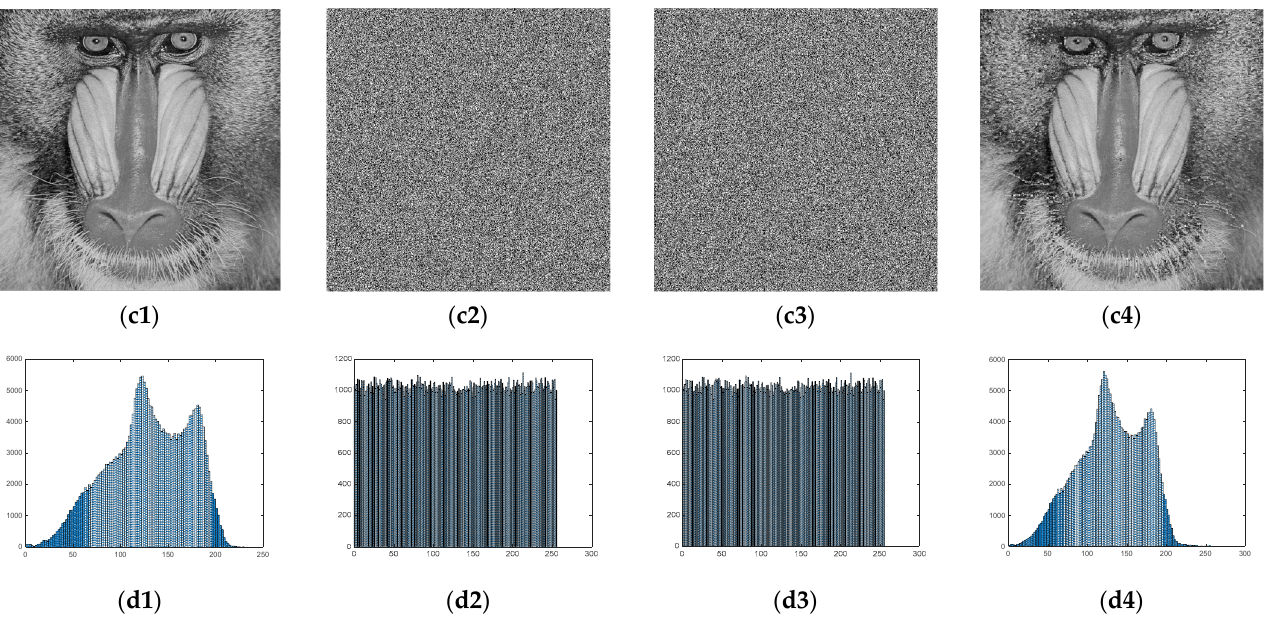
Figure 8. Execution results of our proposed scheme: ( a1 ) The original “Airplane” image with 512 × 512 pixels. ( a2 , a3 ) are the encrypted image and embedded encrypted image (the number of sub-blocks = 8, codebook size = 64, block size = 4 × 4, and γ = bpp). ( a4 ) is the decrypted image (PSNR = dB). ( b1 – b4 ) are the corresponding histograms of ( a1 – a4 ). In ( c , d ), the results of “Baboon” (the number of sub-blocks = 4, codebook size = 128, block size = 16 × 16, γ = 0.0179 bpp, and PSNR = Inf dB) are given.